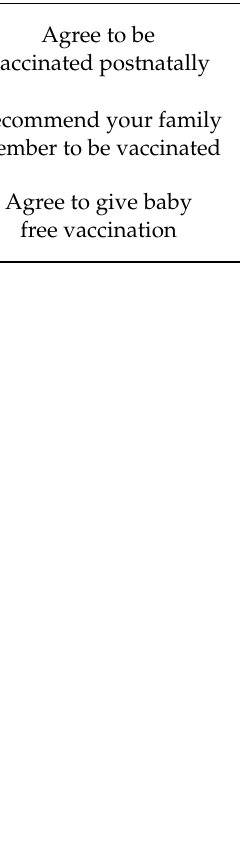
Table 5. Univariate analysis on demographic characteristics and knowledge scores of pertussis